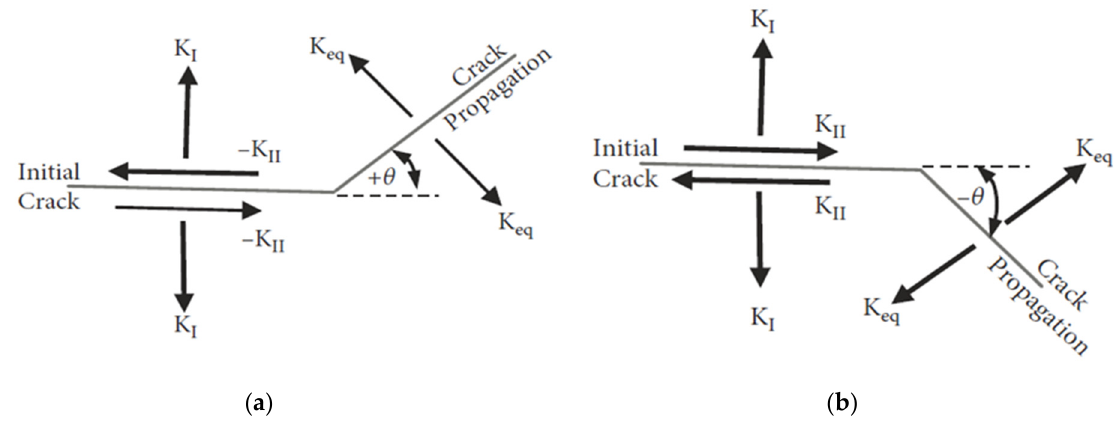
Figure 4. Crack growth angle: ( a ) K II > 0 and ( b ) K II < 0.